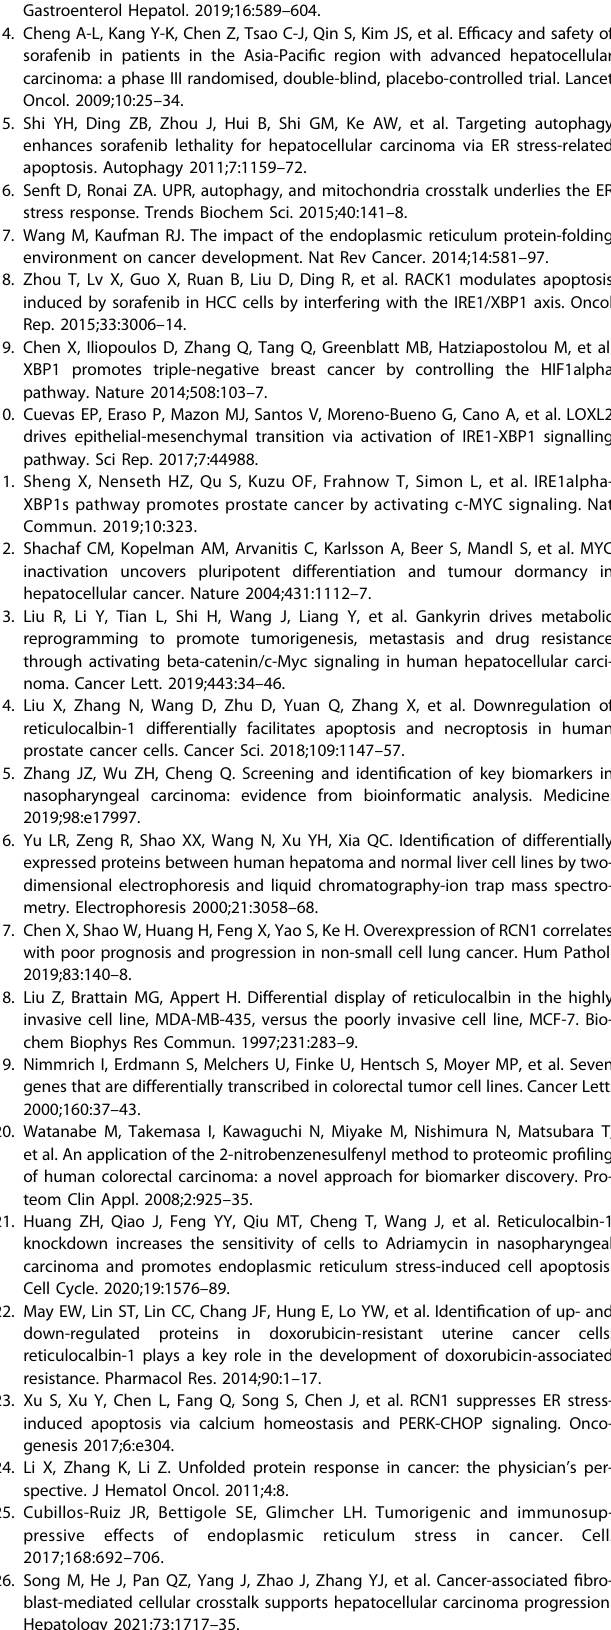
in Supplementary Table S2. IRE1 , MYC , and XBP1s cDNA was also inserted into pcDNA3.1 or pcDNA3.1-Flag vectors, and the empty vector was used as a negative